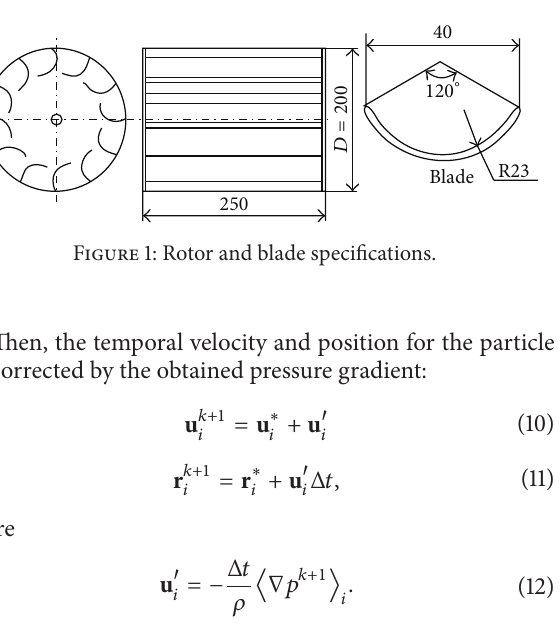
Figure 2: Positional relation between waterfall and rotor.